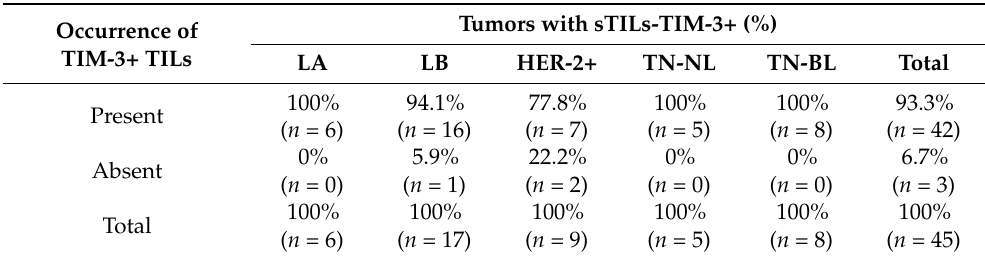
Table 4. Percentages (%) and frequencies ( n ) of tumors with TIM-3+ expression in stromal TILs (sTILs-TIM-3+) among the 45 FMC stratified according to their molecular subtype (luminal A (LA), luminal B (LB), HER-2+, triple-negative normal-like (TN-NL), and triple-negative basal-like (TN-BL)). Occurrence of TIM-3+ TILs Present Absent Total